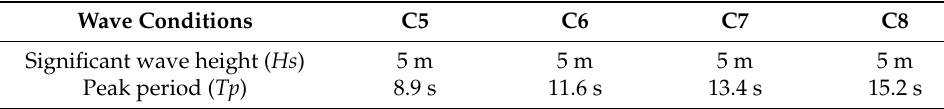
Table 8. Typical wave conditions under different wave periods.